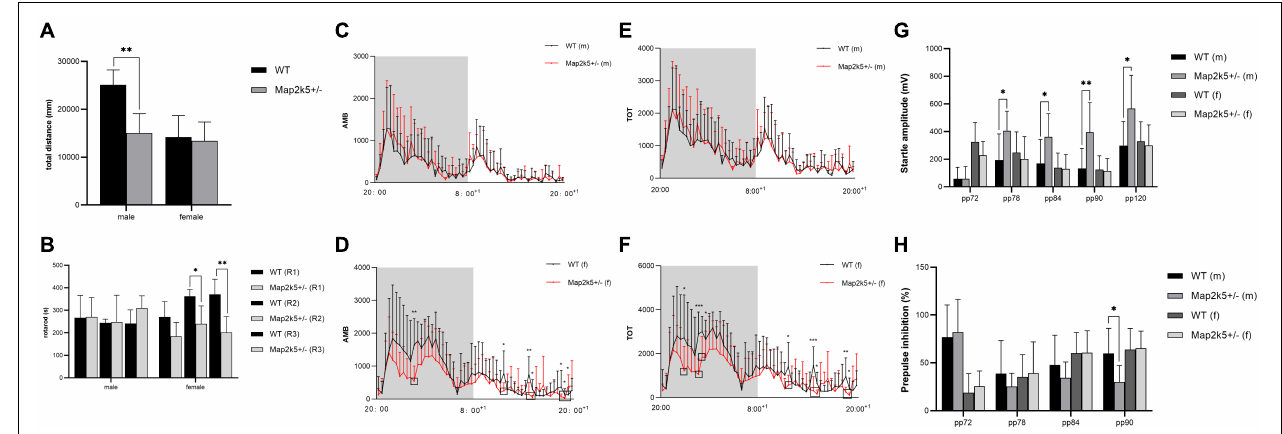
FIGURE 3 | (A) Open field test to measure volitional locomotion. Male Map2k5 + / − mice displayed a decreased total distance compared with WT mice in traveled in open field test (P = 0.004, n = 4). (B) Rotarod test. Female Map2k5 + / − mice have impaired coordination ability in rounds 2 and 3 ( P 1 = 0.157, P 2 = 0.036, P 3 = 0.003, n = 4). (C–F) Total activity (TOT) and ambulatory activity (AMB) with 12 h (light)–12 h (dark) cycle in both male (C,E) and female mice (D,F) . AMB and TOT were decreased significantly in female Map2k5 + / − mice during their light phase (rest phase) ( n = 8). (G,H) Acoustic startle response (ASR) and prepulse inhibition (PPI) of WT and Map2k5 + / − mutant mice. (G) ASR increased in male Map2k5 + / − mutant mice at 78, 84, 90, and 120 dB ( P = 0.035, 0.029, 0.006, and 0.019, respectively). (H) Prepulse inhibition (PPI) was decreased in male Map2k5 + / − mutant mice at 90 dB ( P = 0.024, n = 6). Results are plotted as mean with SEM. Bars represent means with SEM. * P < 0.05, ** P <